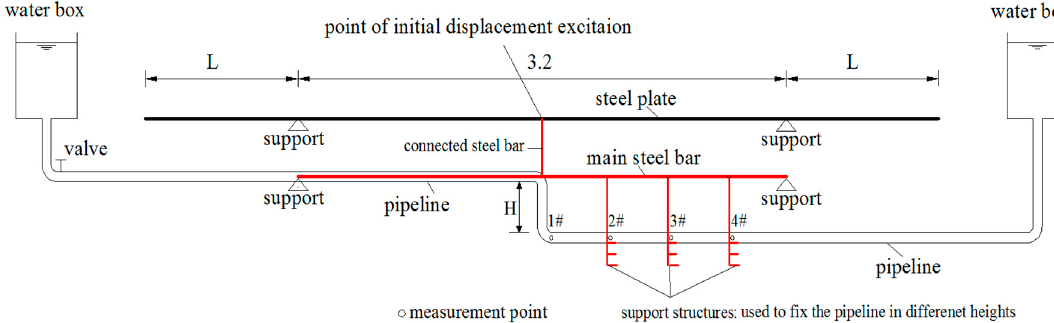
Figure 10. Design layout of the test model and step-type LLSS (unit: m).